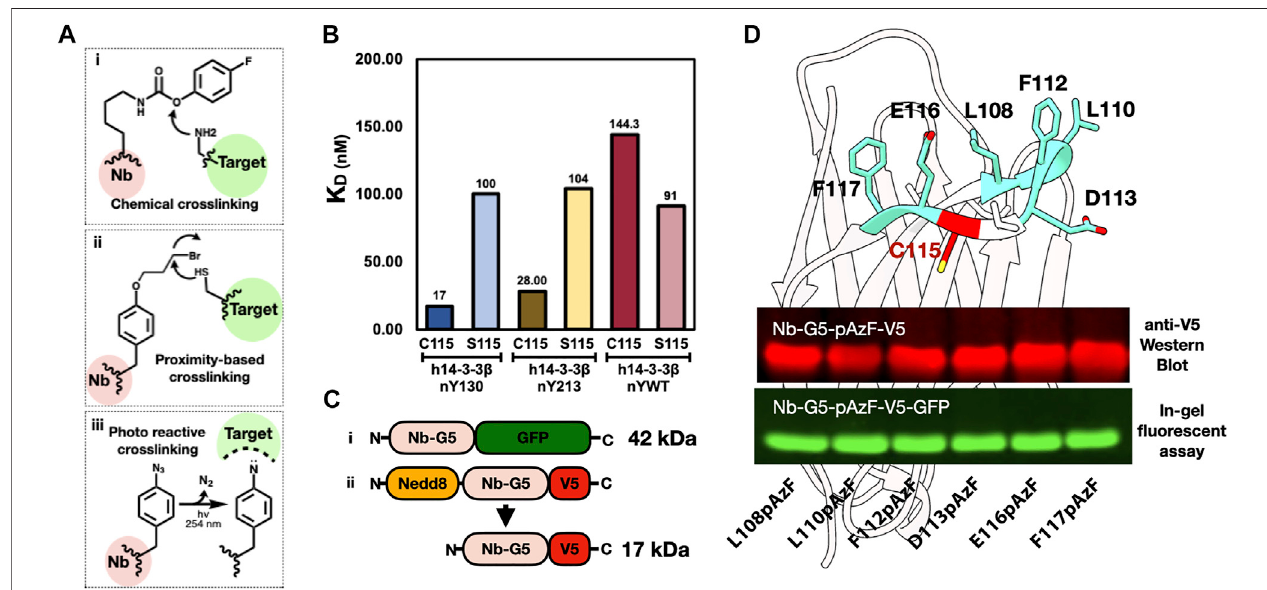
FIGURE4| Generatingananti-nitroTyrcross-linkingtool. (A) .Examplesofthreecommoncrosslinkingstrategies:(i)Chemicalcrosslinkers,suchasthecarbamate- containingncAAFPheK,displayahighreactivitytoproximalnucleophilicresidues(e.g.,Lys,Cys,andTyr)underweaklybasicconditions(Xuanetal.,2017);(ii)Proximity- basedcrosslinkers,suchasthehaloalkanencAAshown,reactwithCysresiduesinthetargetproteinfacilitatedbyanincreasedlocaleffectiveconcentration(Xiangetal., 2014); and (iii) Photoreactive crosslinkers, such as benzophenones, diazirines, and azides (as in the azidoPhe ncAA shown), contain UV-induced cross-linking moietiesthatreact withdiverse proximal groups(Hoffmann2020). (B). K D sofNb-G5and Nb-G5(C115S)against nitrated and WT14-3-3 areshown. (C) .Constructsof Nb-G5-GFP (i) and Nedd8-Nb-G5-V5 (ii). (D) . A model of Nb-G5, generated by ABodyBuilder: automated antibody structure predictor (Leem et al., 2016). The CDR3 loop unpaired cysteine (C115) is indicated in red and the adjacent resides individually substituted with azidoPhe are colored teal and labeled. An anti-V5 western blot image (top panel) and an in-gel fl uorescence assay (bottom panel) show both kinds of azidoPhe-encoded Nb-G5 constructs expressed